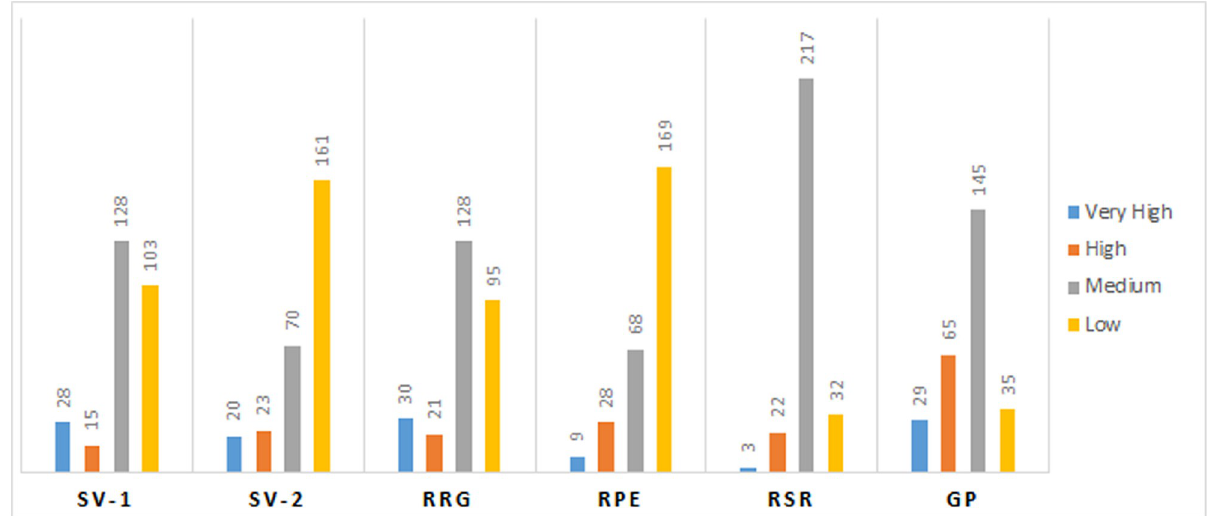
Fig 1. Frequency distribution of germplasm lines for each of the seedling stage physiological parameters for SVI-1, SVI-2, RRG, RPE, RSR and GP estimated from 274rice landraces.